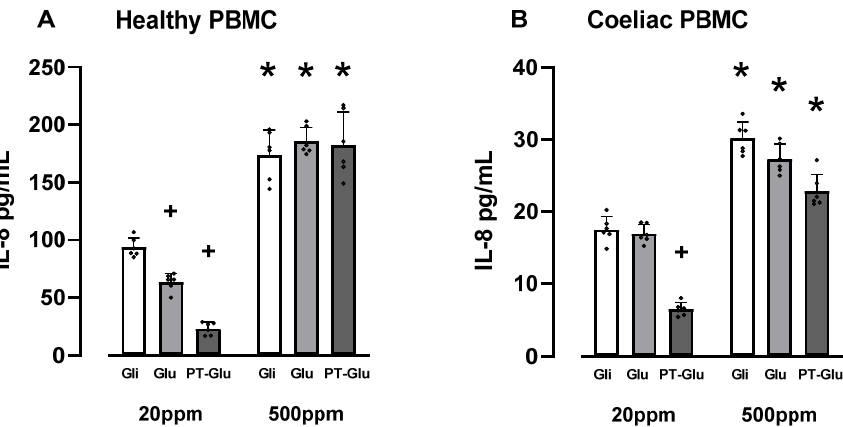
Figure 3. 500 ppm of crude gliadin, gluten and pepsin-trypsin digested gluten evoked an increase in IL-8 protein expression in PBMCs from both healthy and coeliac donors. Digestion by pepsin and trypsin significantly decreased IL-8 protein levels in both healthy and coeliac PBMCs. * represents significant difference as compared with the 20 ppm comparator group, p < 0.05; + represents significant difference as compared with all other groups, p < 0.05.